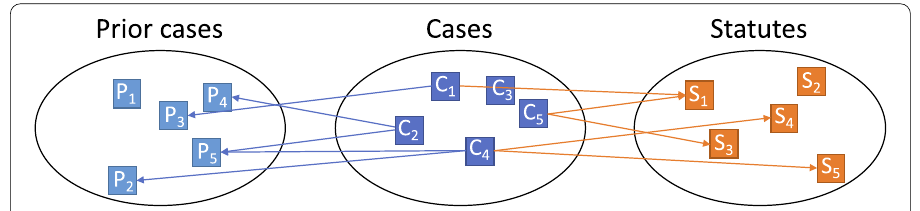
Fig. 1 An overview of the structure of the legal case data in the COLIEE